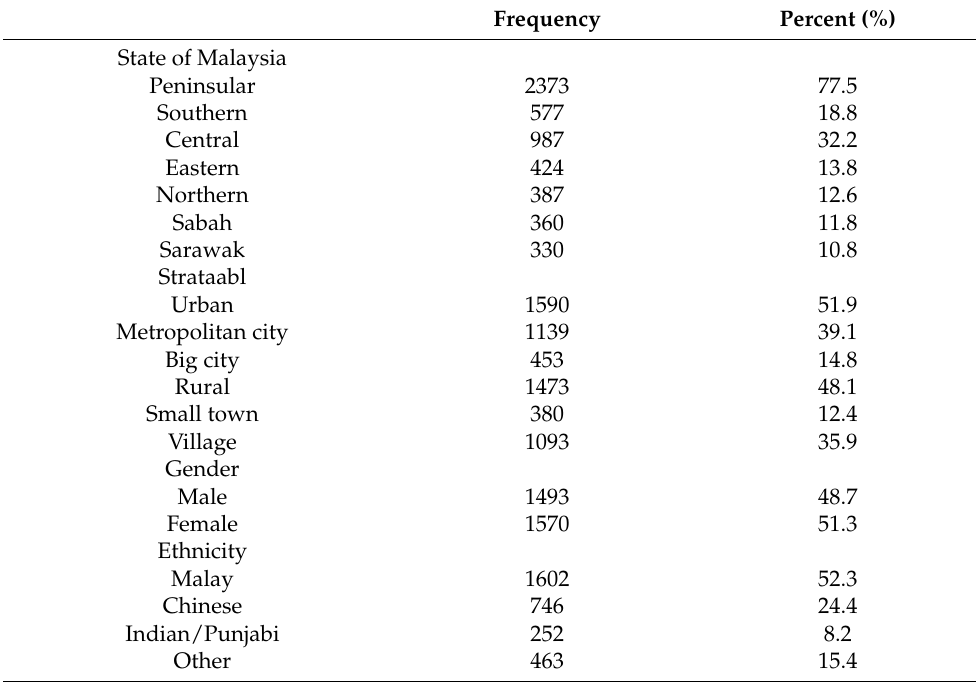
Table 1. Frequencies and percentages for socio-demographic characteristics of the respondents ( n =